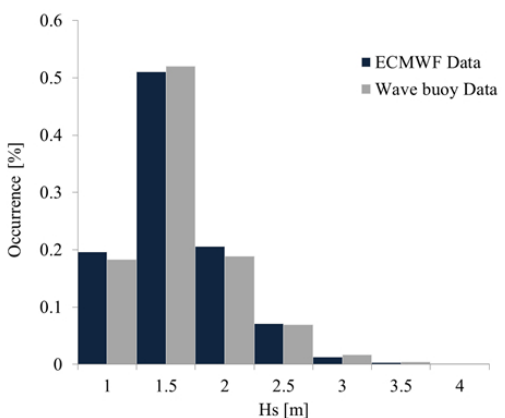
Figure 10. Comparison of measured (1996) and calculated percentage of significant wave height occurrence at site S1.